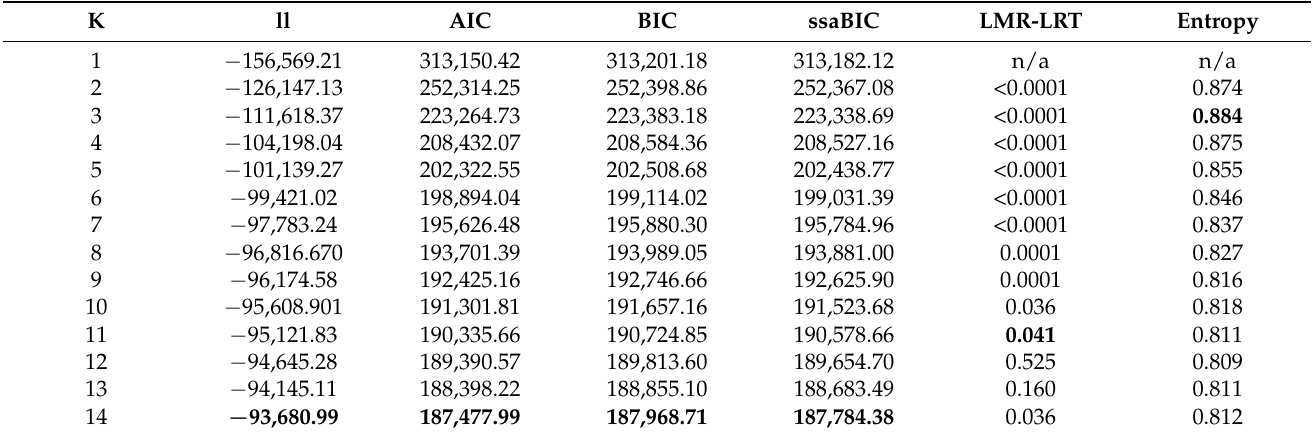
Table 4. Table of fit statistics and entropy for each class